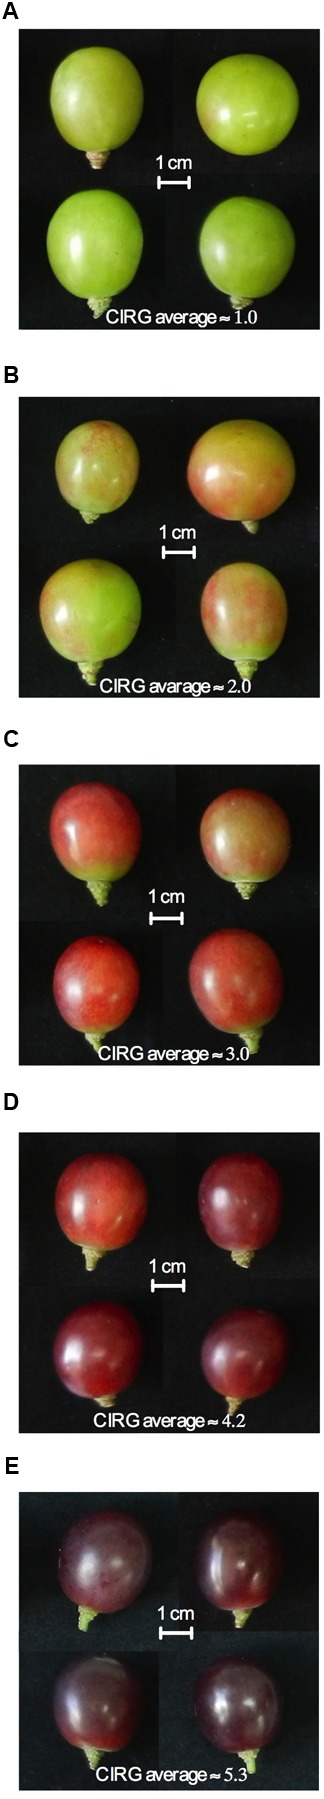
Visual appearance of berries with different mean CIRG values from 1.0 to 5.3 (A–E). In each image, the average CIRG value from the four berries shown is indicated.